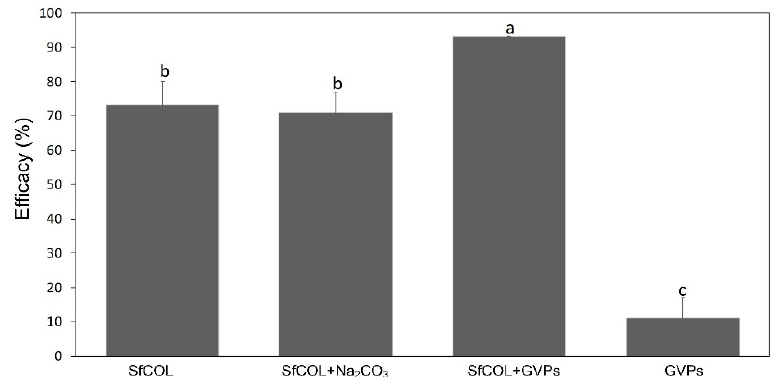
Figure 2. Effect of SfCOL and GVPs on S. frugiperda larvae mortality. Treatment mortalities were corrected with mortality in the control to estimate efficacy. Bars labelled with the same letters did not differ significantly according to Tukey test (95%). Error bars indicate the standard deviation (SD).